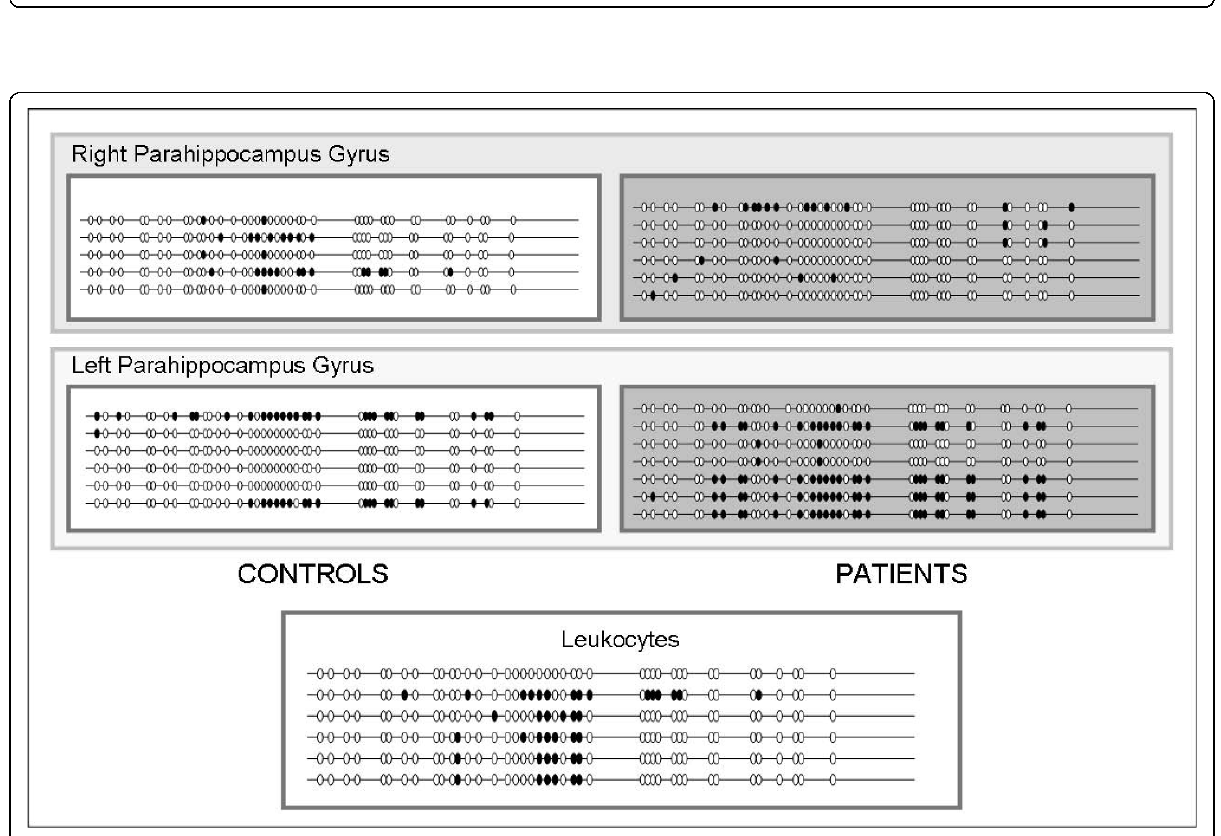
Figure 2 CpG dinucleotides in the context of the CpG island located in transcription start site . The thin black line corresponds to the sequence of DNA. Below this, a single black bar corresponds to the predicted CpG island location. Distances in base pairs to +1 site are included, as well as an arrow indicating the start site of exon s1. Primers for both regions analyzed, CG1 and CG2 are indicated with arrows.